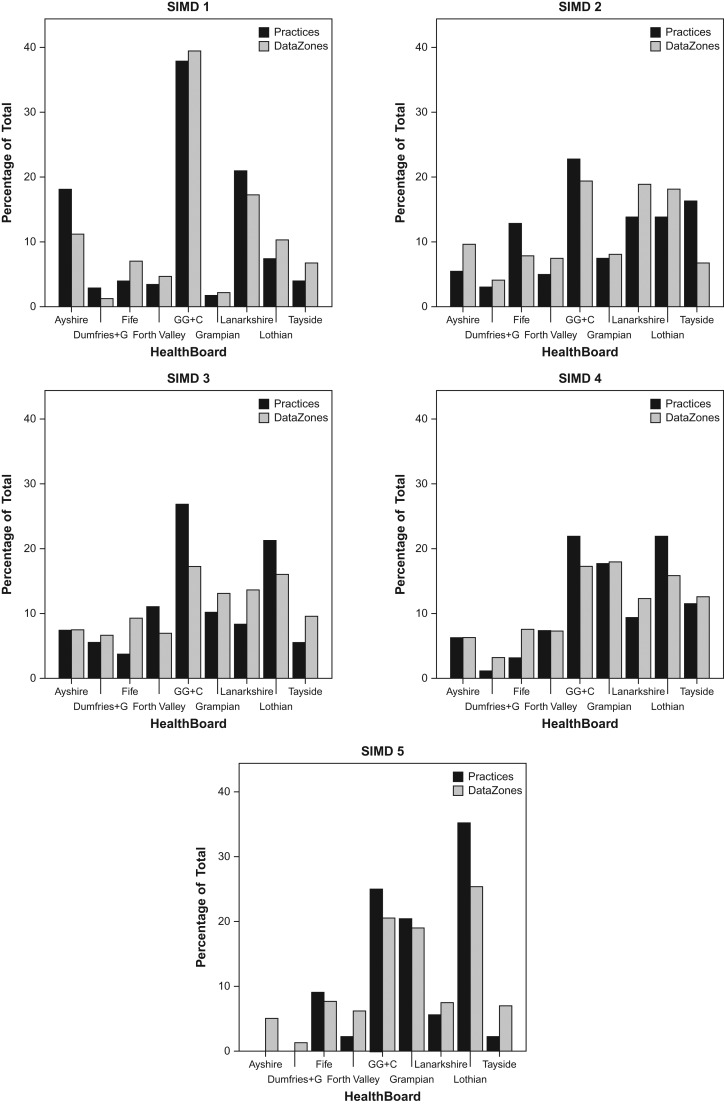
Percentage of all optometric practices in each quintile versus percentage of all Data Zones in each quintile, arranged by Health Board. In each chart grey bars represent % of total number of Data Zones whilst black bars represent % of total number of practices. This indicates, for example, that in instances where the black bar is smaller than the grey bar there may be an under-provision of practices within the corresponding Health Board.